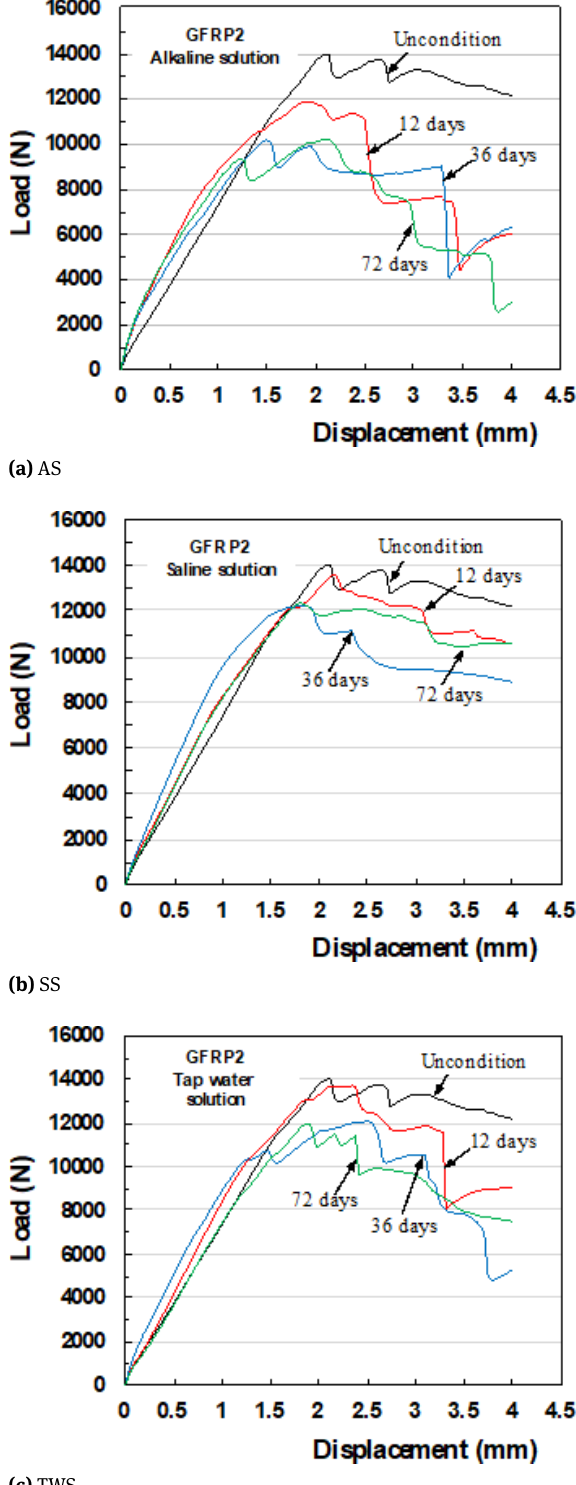
Figure 11: Load-displacement curves of GFRP2 bars in the short- beam shear